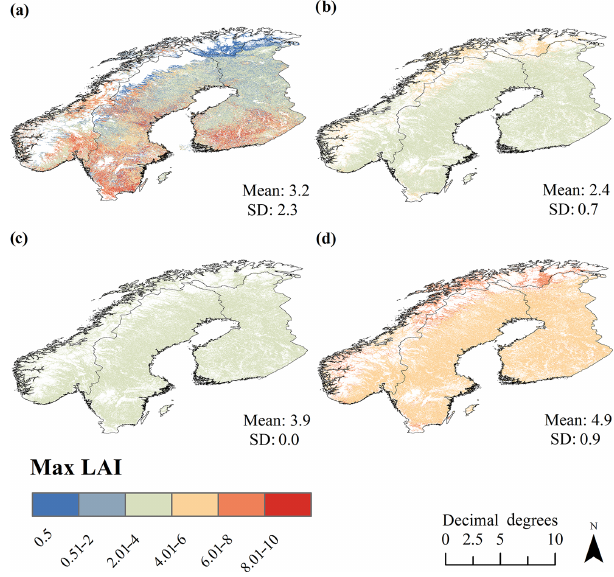
Figure 6. Demonstration of how the enhanced LC product and the related LUT may be used to map local variations in important struc- tural attributes in forests, such as maximum growing season LAI (max LAI or LAI max ) . Maps of LAI max in Fennoscandic forests using (a) our enhanced LC product and the related LUT, (b) ESA LC product and PFT-dependent LAI max values used in JSBACH, (c) ESA LC product and PFT-dependent LAI max values used in ORCHIDEE, and (d) ESA LC product and PFT-dependent LAI max values used in JULES. For colors, see the online version of the arti-